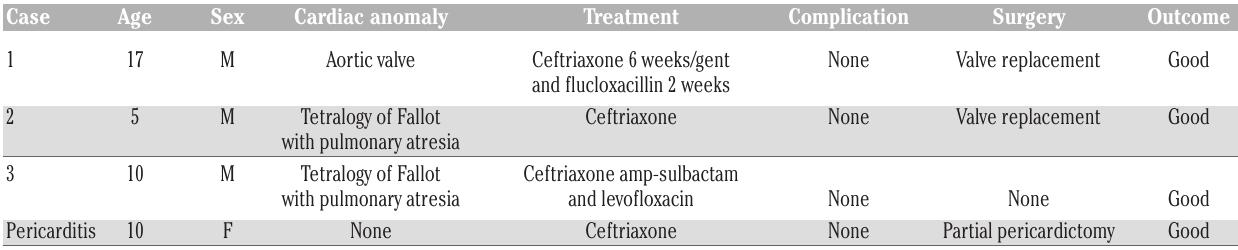
Table 2. A summary of pediatric case reports of C.